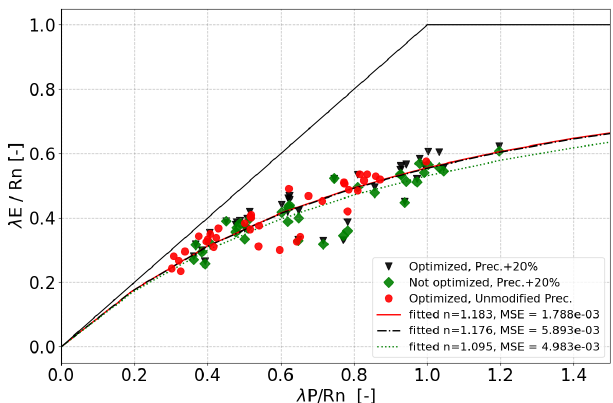
Figure 5. VOM results along the NATT in Budyko space as a result of modified precipitation for 36 additional locations. Black trian- gles denote fully optimized simulations with modified precipitation, while green diamonds denote simulations where the VOM was run with the optimal vegetation properties determined for an unmodi- fied climate (red dots). Lines are fits of Eq. (3) to the data points of the same